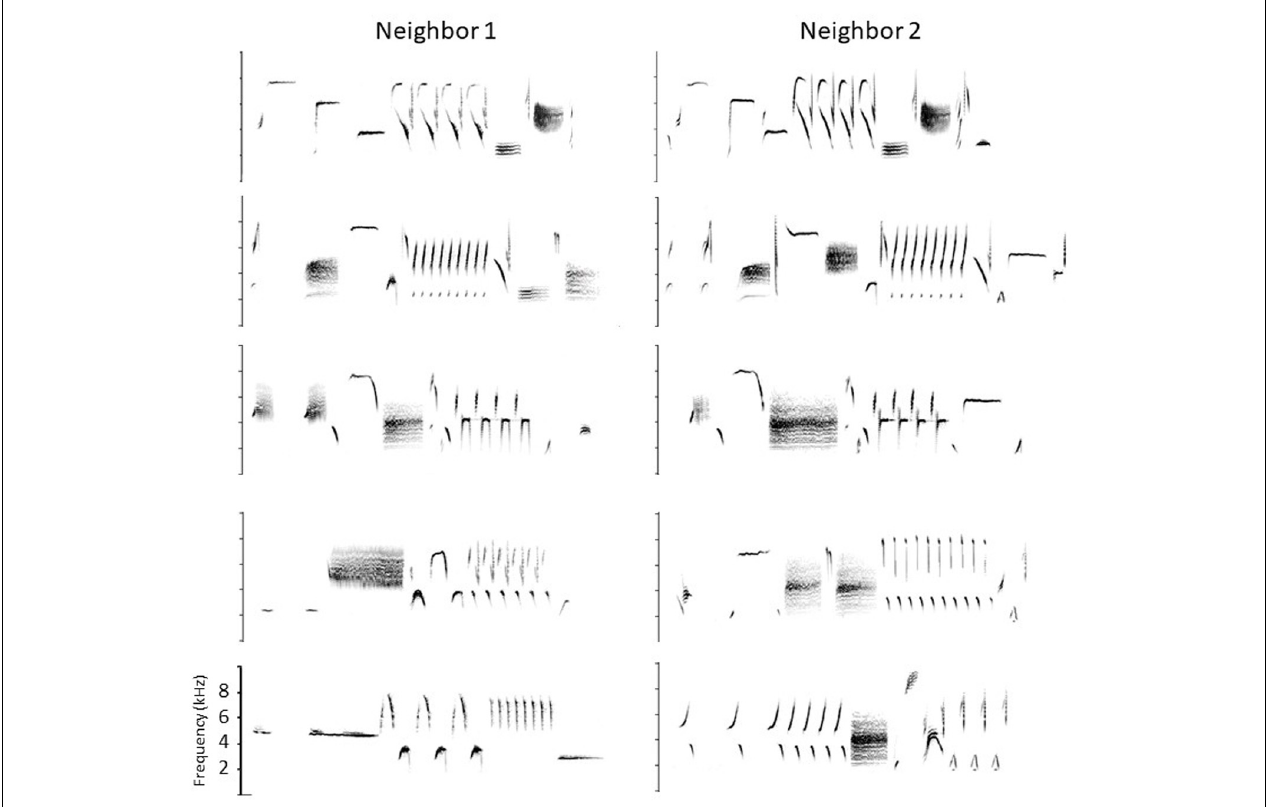
FIGURE 1 | Partial song repertoires of two neighboring birds. Shared songs are shown in the top three rows, and four of their unshared songs in the bottom two rows (they are arbitrarily paired). Frequency scale: 0–10 kHz. Songs are 2–3 s